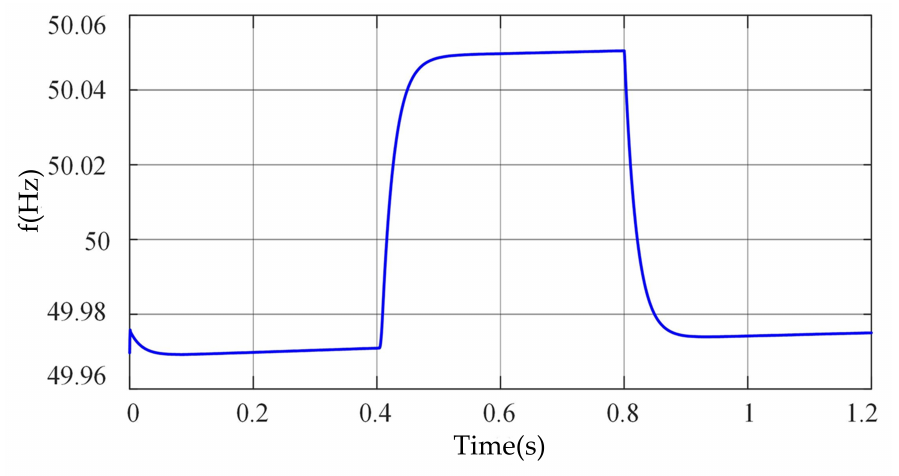
Figure 10. Active power variation result of case-2.